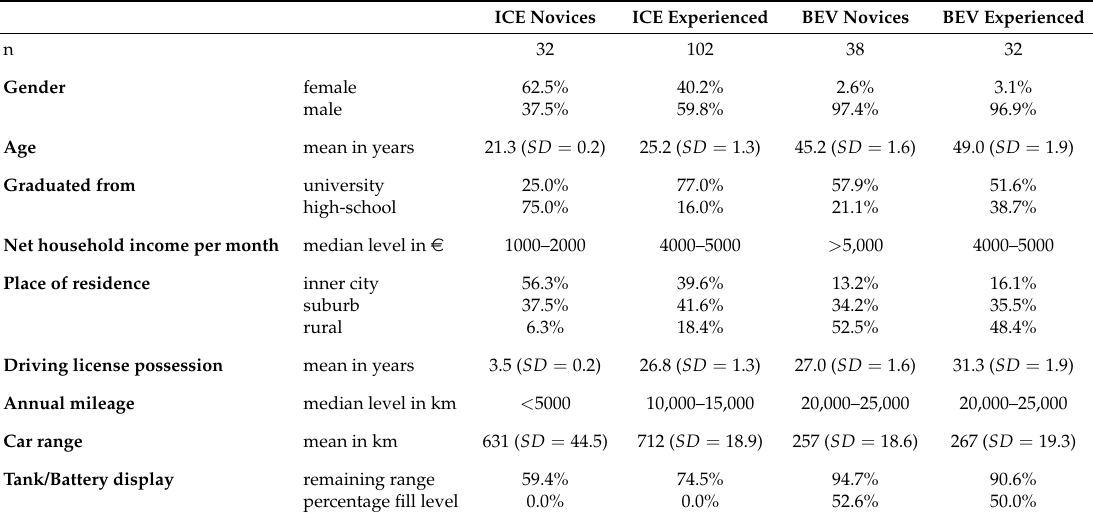
Table 3. User characteristics of experience